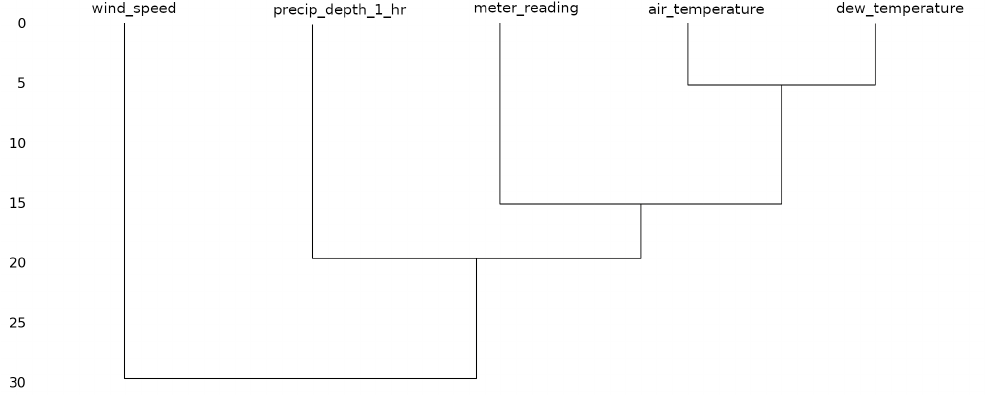
Figure 5. Dendrogram generated using selected